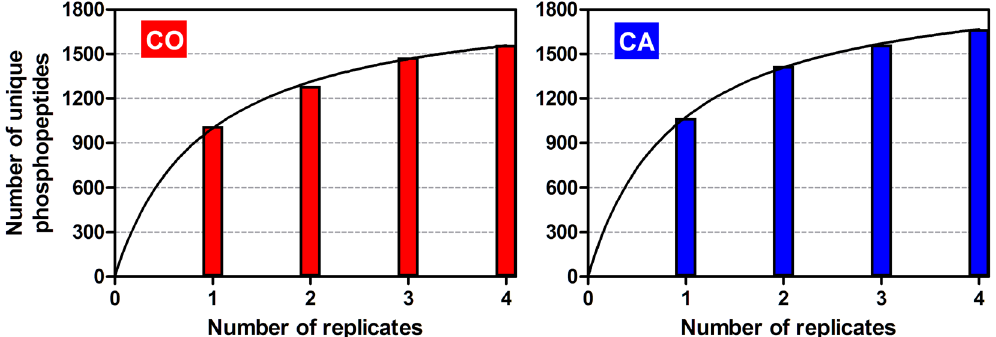
Figure 4. Saturation curves in CA (blue) and CO (red) conditions. The horizontal axis depicts the number of biological replicates and the vertical axis the cumulated number of unique phosphopeptides in each of these replicates. The lines represent non-linear curve fitting (details about the equation are in the text).